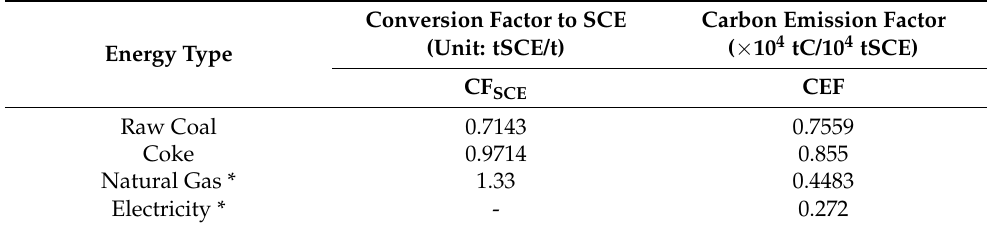
Table A2. Conversion factor of power generation coal to standard coal equivalent (SCE) and CO 2 emission factor for different fuel